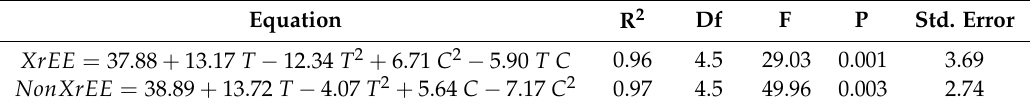
Table 2. Equations yielded for the dependent variable (EE) as a function of the independent variables (RES/polymer ratio and temperature, normalized values) for the experimental design.